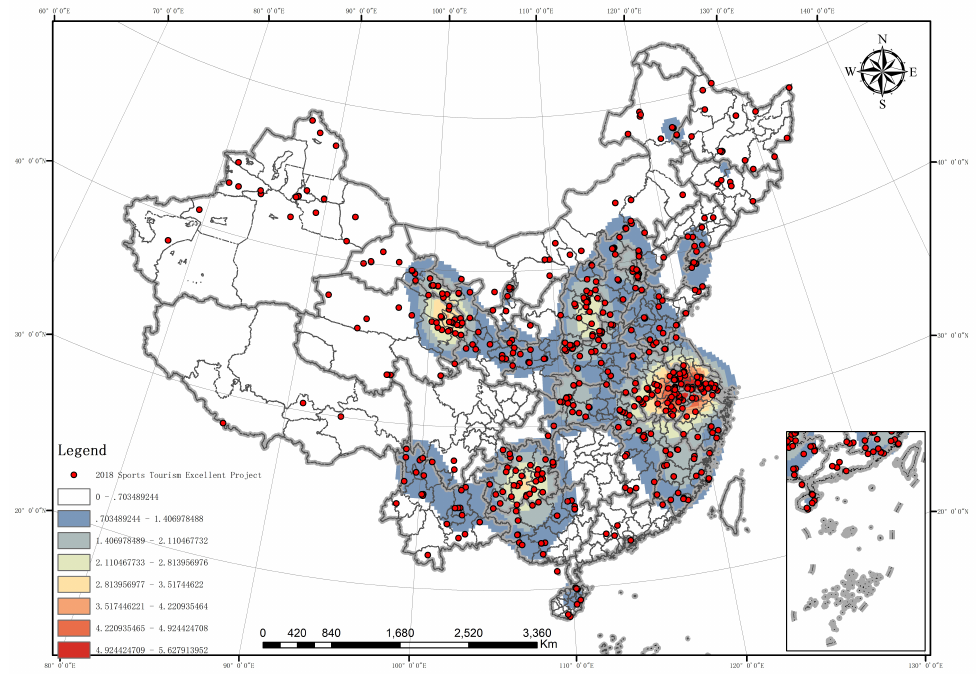
Figure 5. Distribution of core density of China’s sports tourism resources in 2018. The color in the figure changes from gray to red: the redder the color, the more clustered the sports tourism projects. See the nuclear density index as shown in the legend for